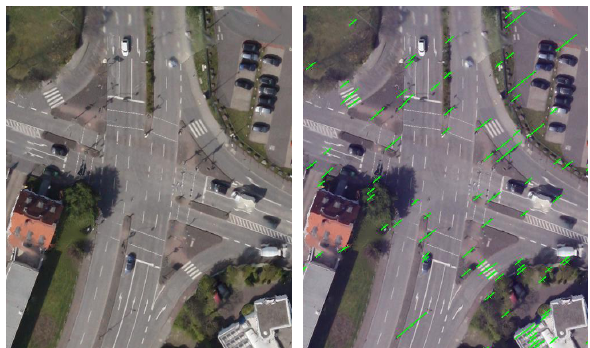
Figure 8. Section 75 × 90 m 2 of crossing “Am Seedamm/Eschborner Landstraße” in Frankfurt am Main (Germany), left: aerial image, GSD 15 cm, right: same image, detected poles overlaid